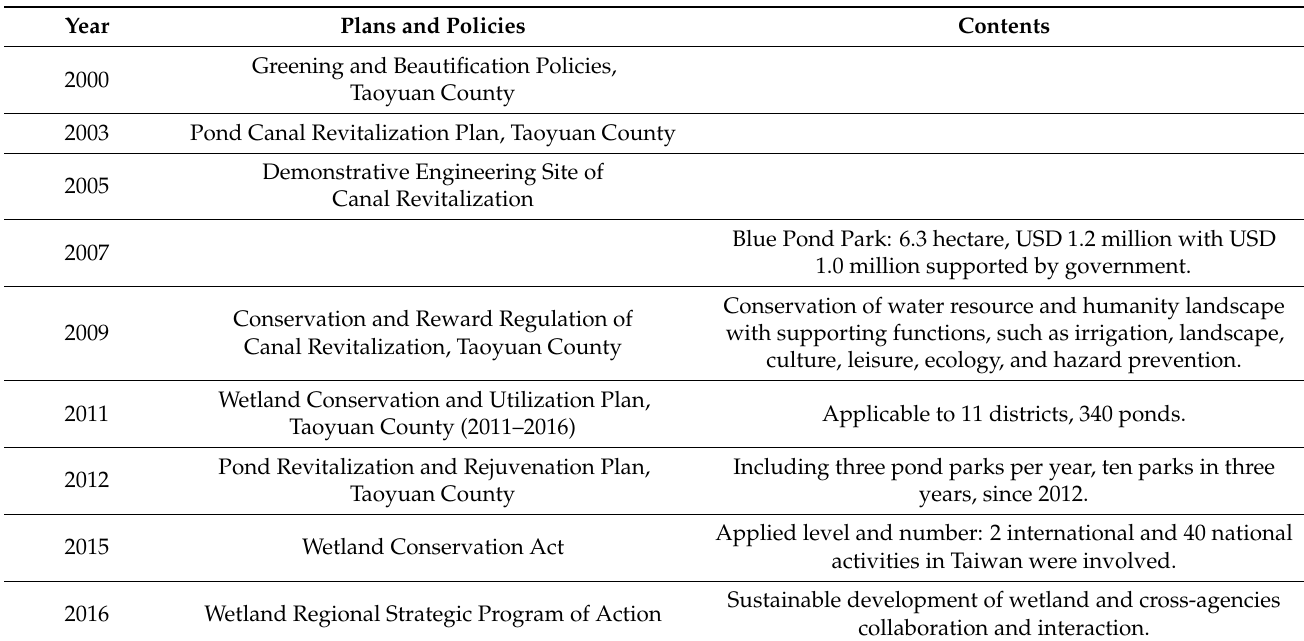
Table 2. Planning strategy for the development of ponds by the government [54], adapted from Urban and Rural Develop- ment Branch; [58], adapted from Ministry of Interior; [59], adapted from Ministry of